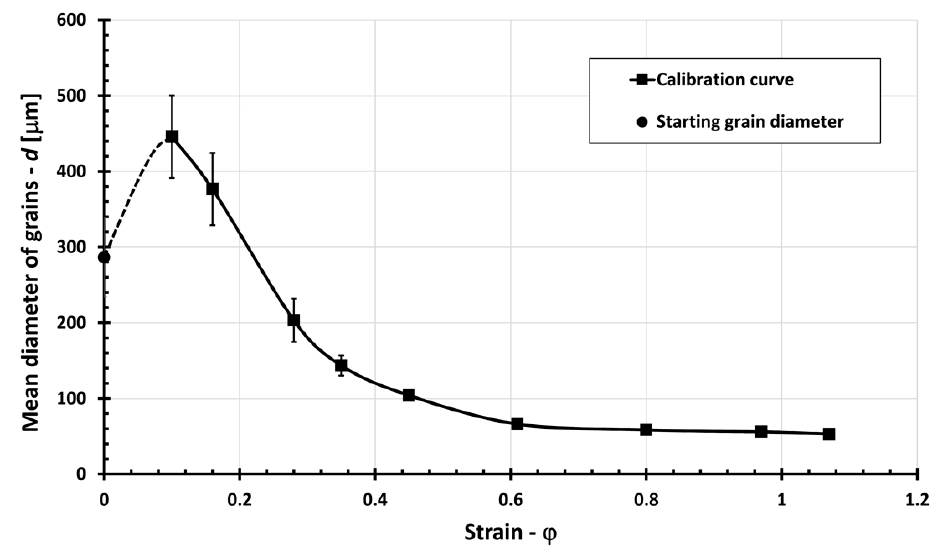
Figure 5. Calibration curve: mean grain diameter vs. strain.